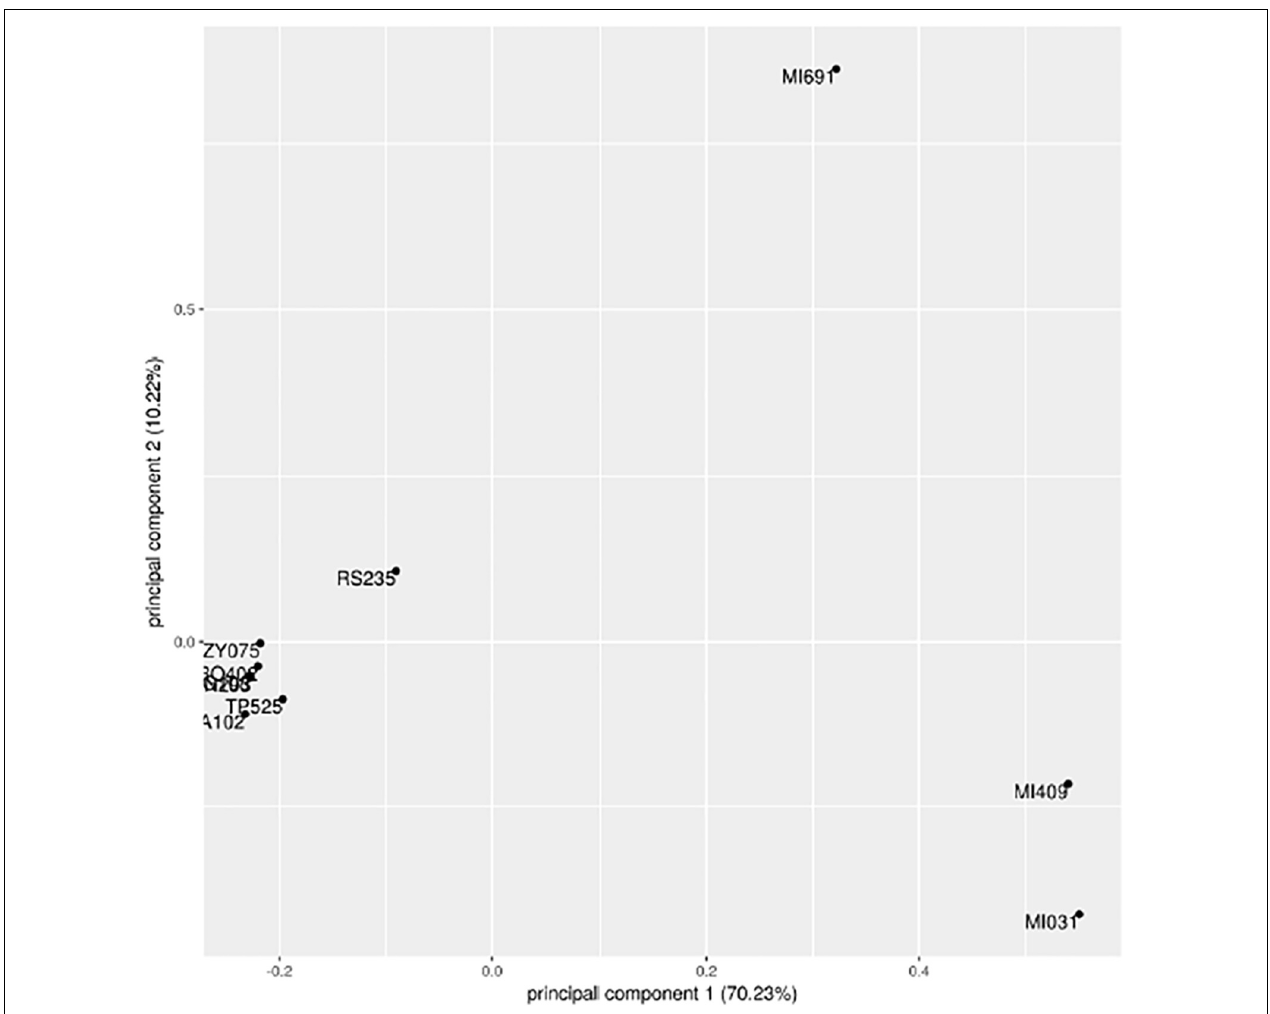
FIGURE 8 | Principal component analysis of 199 informative